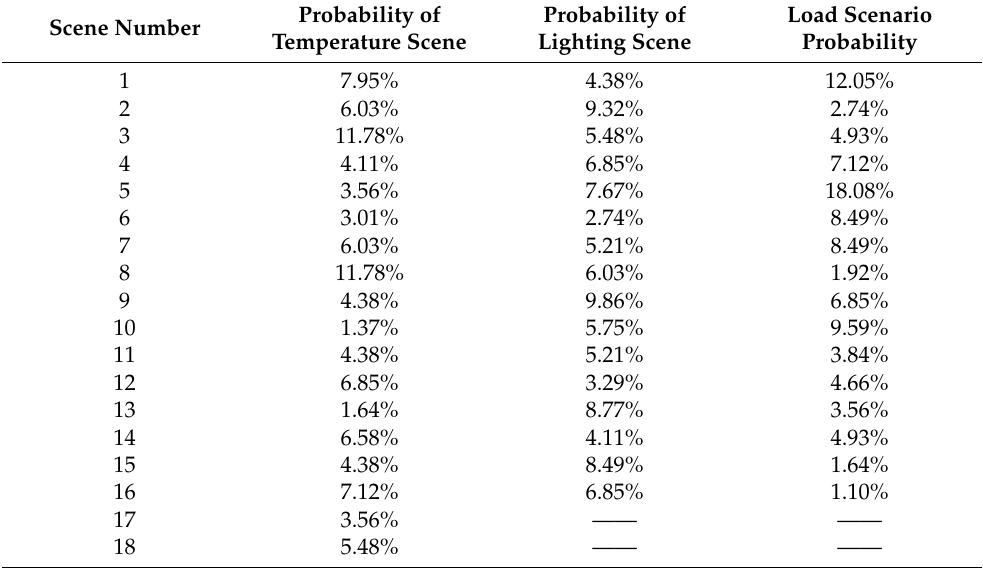
Figure 3. ( a ) Separate clustering results of temperature data; ( b ) Separate clustering results of light intensity data; ( c ) Separate clustering results of load data.